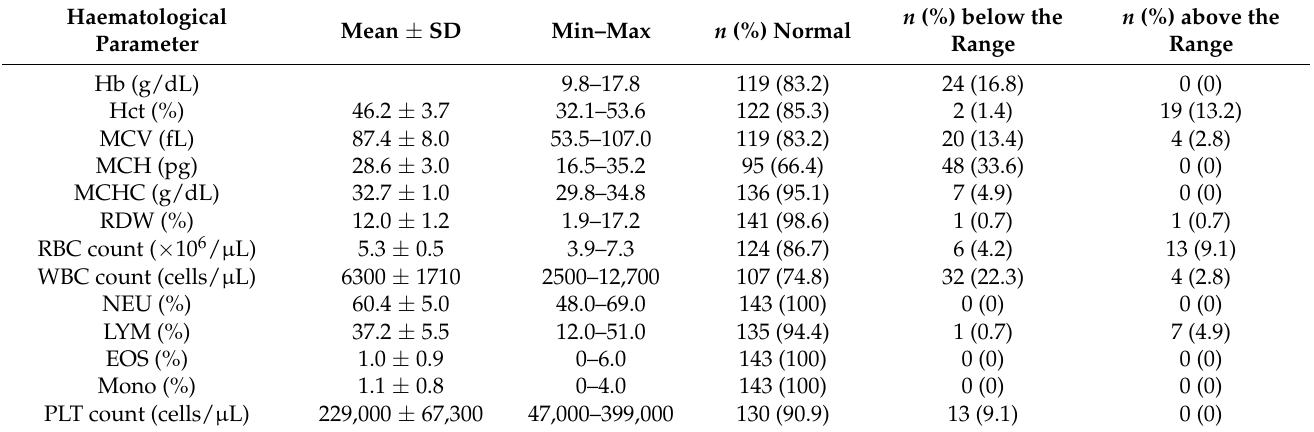
Table 2. Characteristics of haematological parameters among farmworkers ( n =